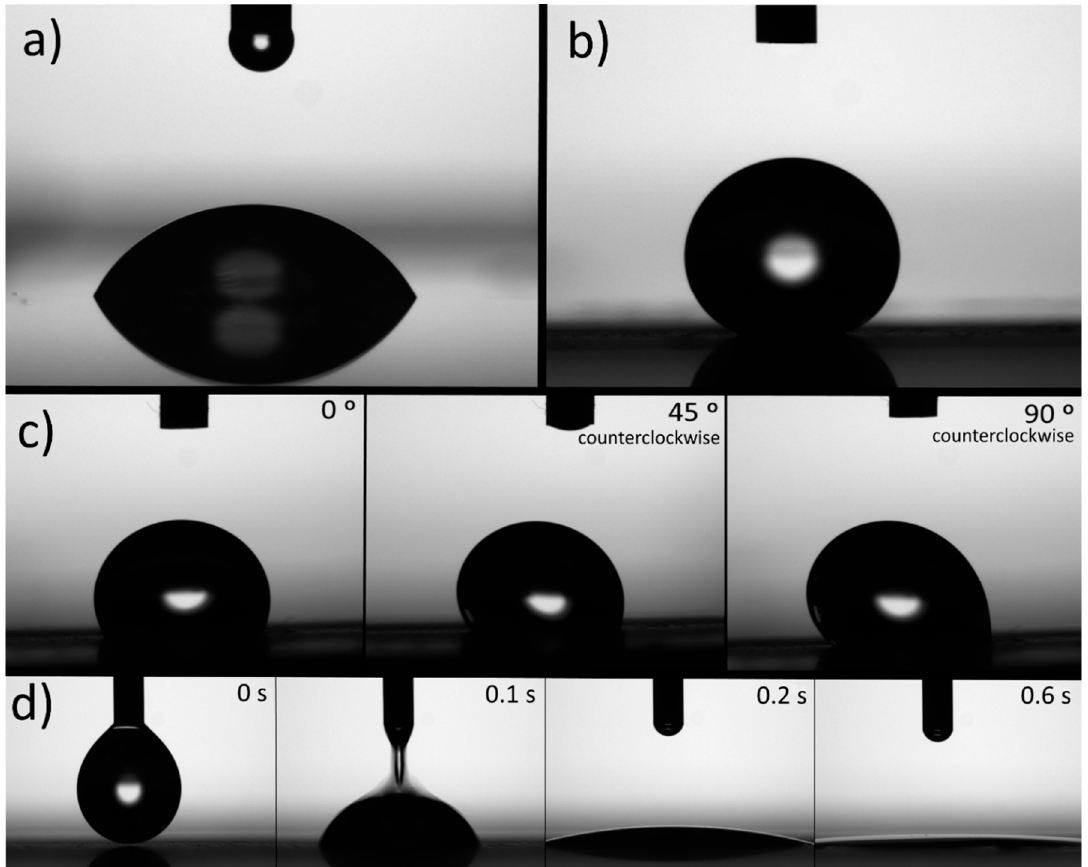
Figure 4 . Images of a water drop deposited on ABS: ( a ) untreated surface; ( b ) surface irradiated by laser 0.9 mm out of focus; ( c ) surface irradiated by laser 1.3 mm out of focus and taken at different tilt angles (the camera rotated simultaneously with the surface); ( d ) time-lapse images of a drop on the surface treated by the laser in focus.